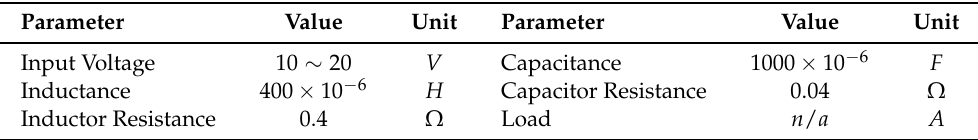
Table 1. System parameters of the studied EHSS. Parameter Value Unit